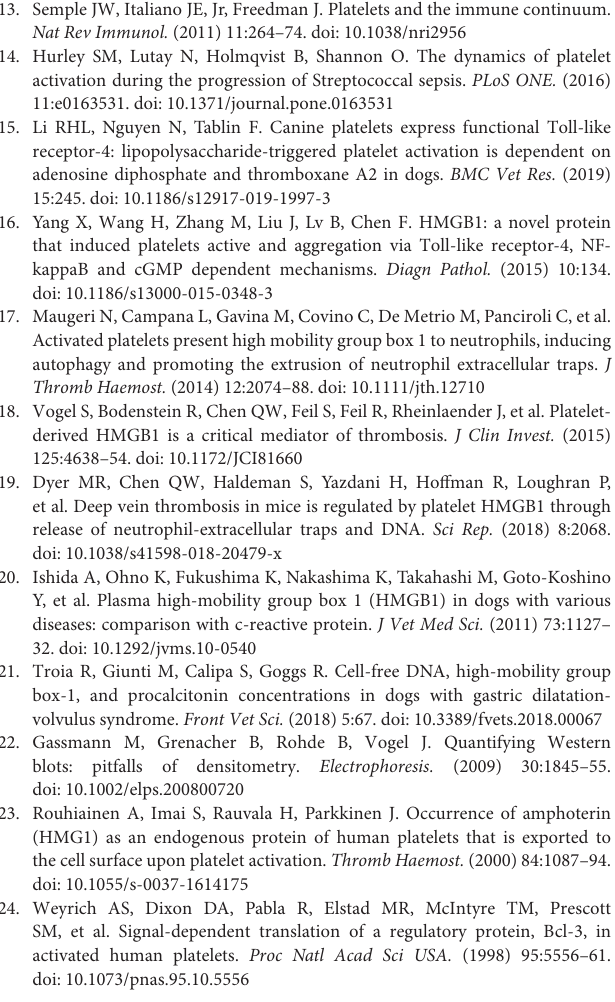
Supplementary Figure 1 | Gating strategies and isotype controls for detecting canine platelets. Representative scatter plot diagram of flow cytometric analysis of gel-filtered platelets from a dog. (A) Platelets were unstimulated, or activated with 10 µ M ADP, or 0.01 U/ml thrombin. Platelets were identified based on their forward (FS) and side scatter (SS) profile. Note the change in FS and SS as platelets were activated in the presence of ADP or thrombin. (B) Fluorescence minus one controls were used to establish gating for P-selectin positive platelets in resting and ADP-activated platelets. (C) Unstimulated platelets from another dog stained with an isotype control or mouse anti-human monoclonal antibodies to CD61 (integrin β 3 ) conjugated to allophycocyanin. Activated platelets in the presence of 0.01 U/ml thrombin were stained with isotype control or biotinylated monoclonal antibodies to CD62P